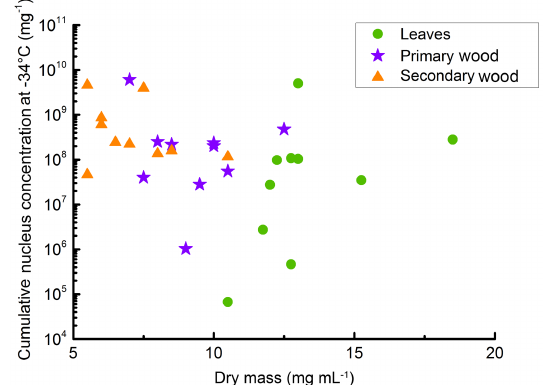
Figure 5. Scatterplot of dry mass (dry residues of the different fil- tered extracts) and cumulative nucleus concentration at − 34 ◦ C per sample mass. The dry mass is the mass we were able to extract with the 50mgmL − 1 suspensions. The data show that secondary wood, which contained mostly the highest INM concentrations and lowest variations between different samples, also contained the lowest ex- tractable mass. Therefore INM ratios in the extractable content of the different samples were highest in secondary wood